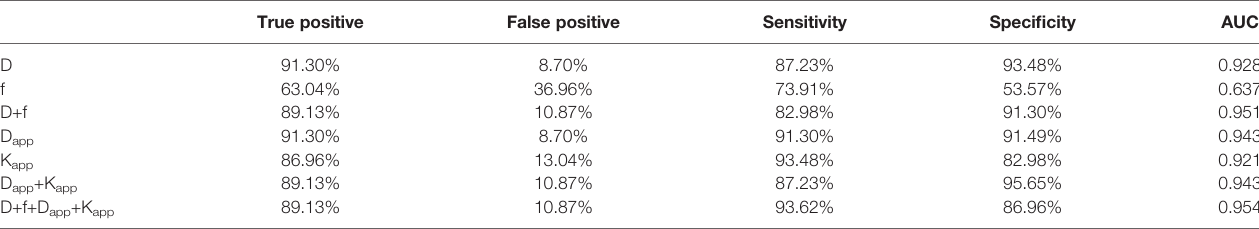
TABLE 5 | The diagnostic performance of the parameters of IVIM and DKI.